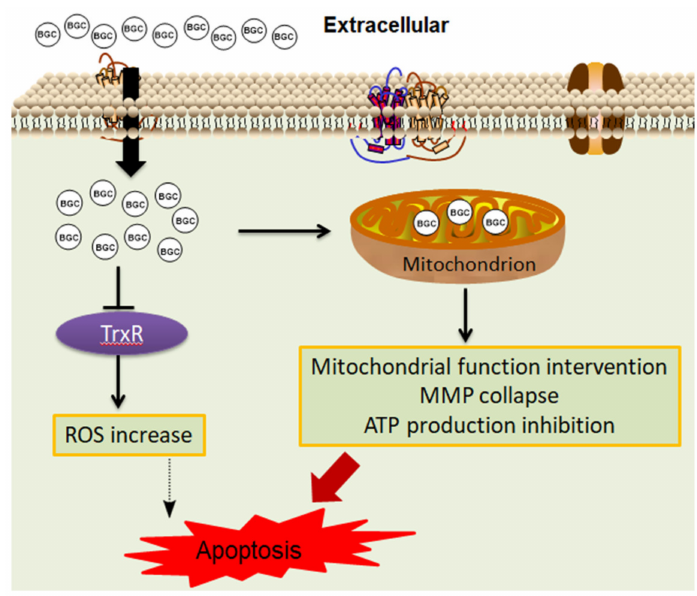
Figure 6. The schematic diagram of the action mechanism of